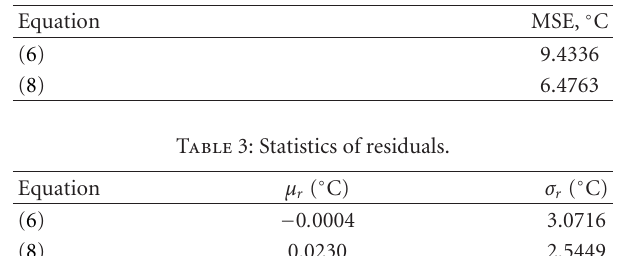
Table 2: Mean square error values.